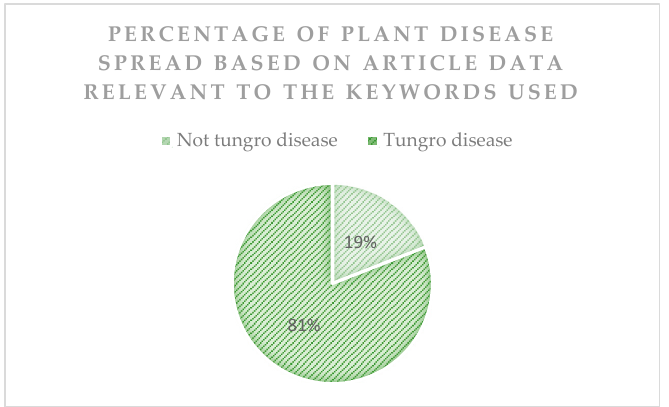
Figure 8. Mathematical modeling percentages on plant diseases.